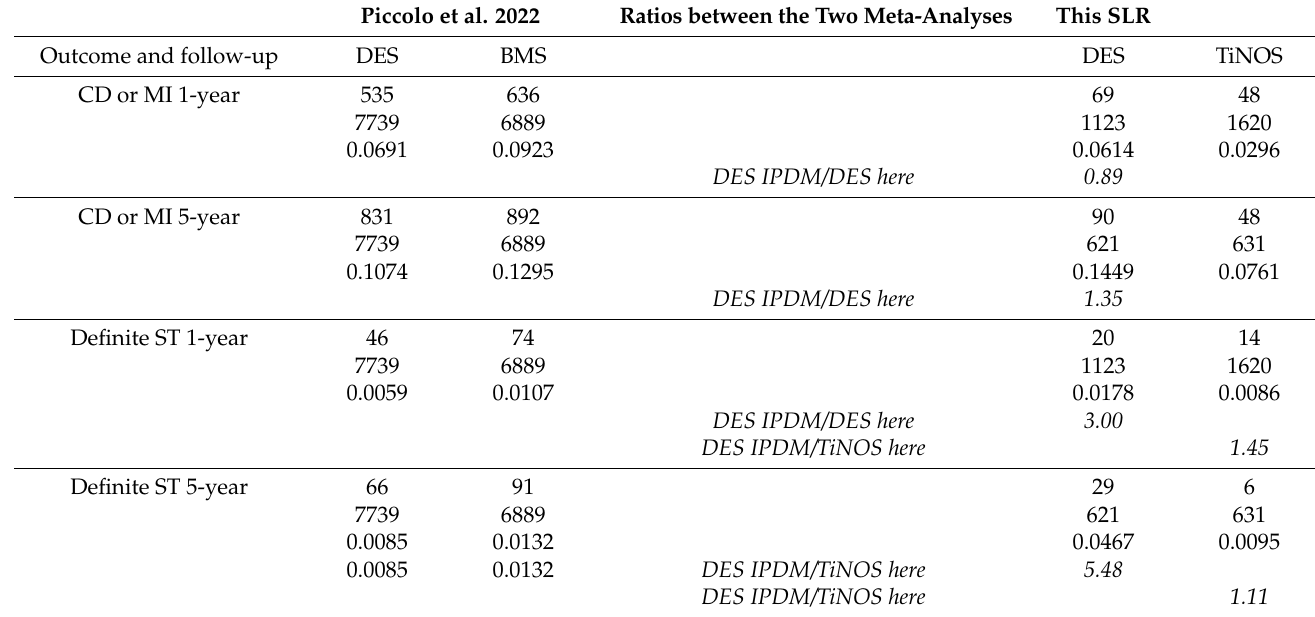
Table 5. Outcome comparison this meta-analysis with Piccolo et al. 2022 IPDM in ACS. Piccolo et al.